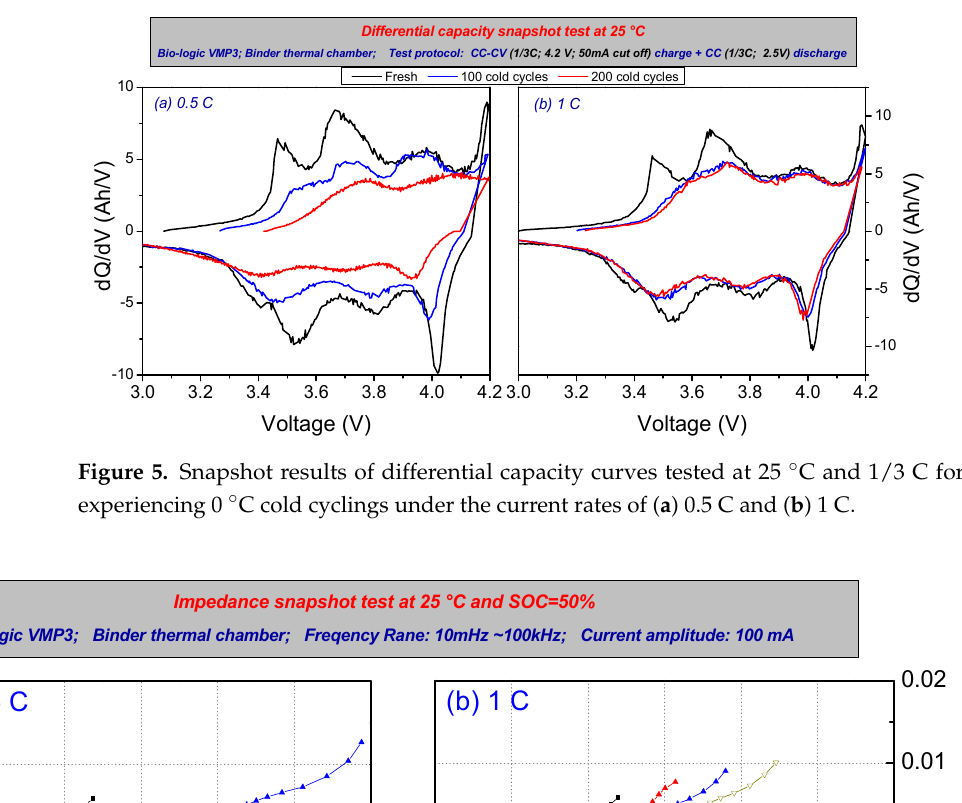
Figure 5. Snapshot results of differential capacity curves tested at 25 °C and 1/3 C for batteries ex- periencing 0 °C cold cyclings under the current rates of ( a ) 0.5 C and ( b ) 1 C.